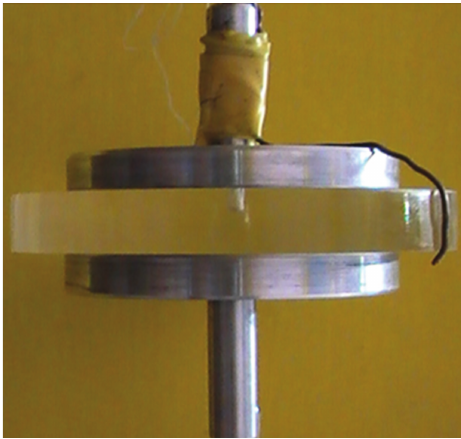
Figure 13: Laboratory model replicating electrode bounded cavity discharges overlapped on air corona discharges (multiple source discharges).